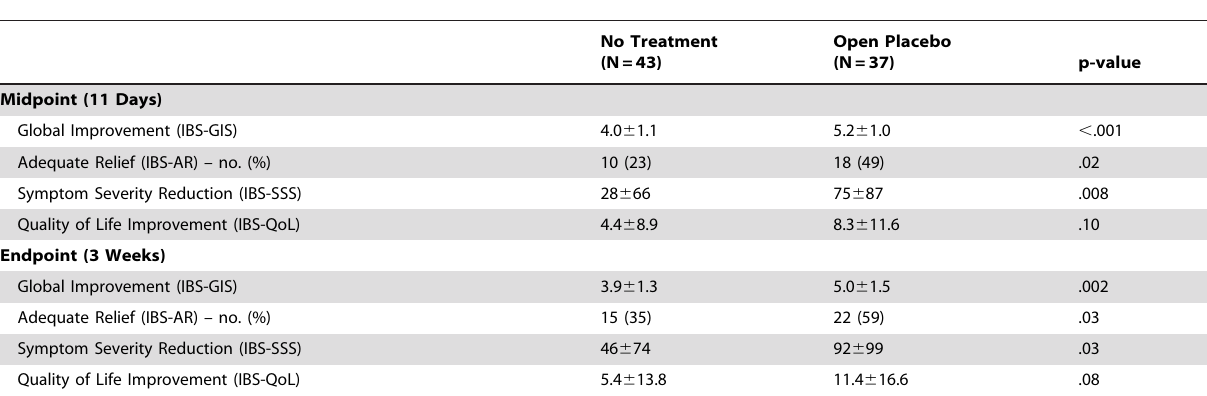
Table 2. Treatment